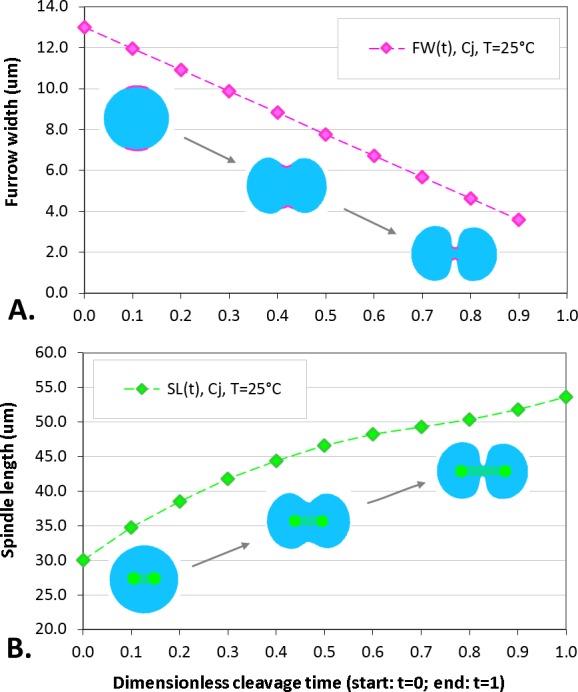
Plots of furrow width (A) and spindle length (B) as a function of dimensionless cleavage time.The values of FW and SL are estimated by a stepwise fitting of our FE cleavage model to Cj data (Hiramoto, 1958), cf. Table 2 (raws 5 and 6).